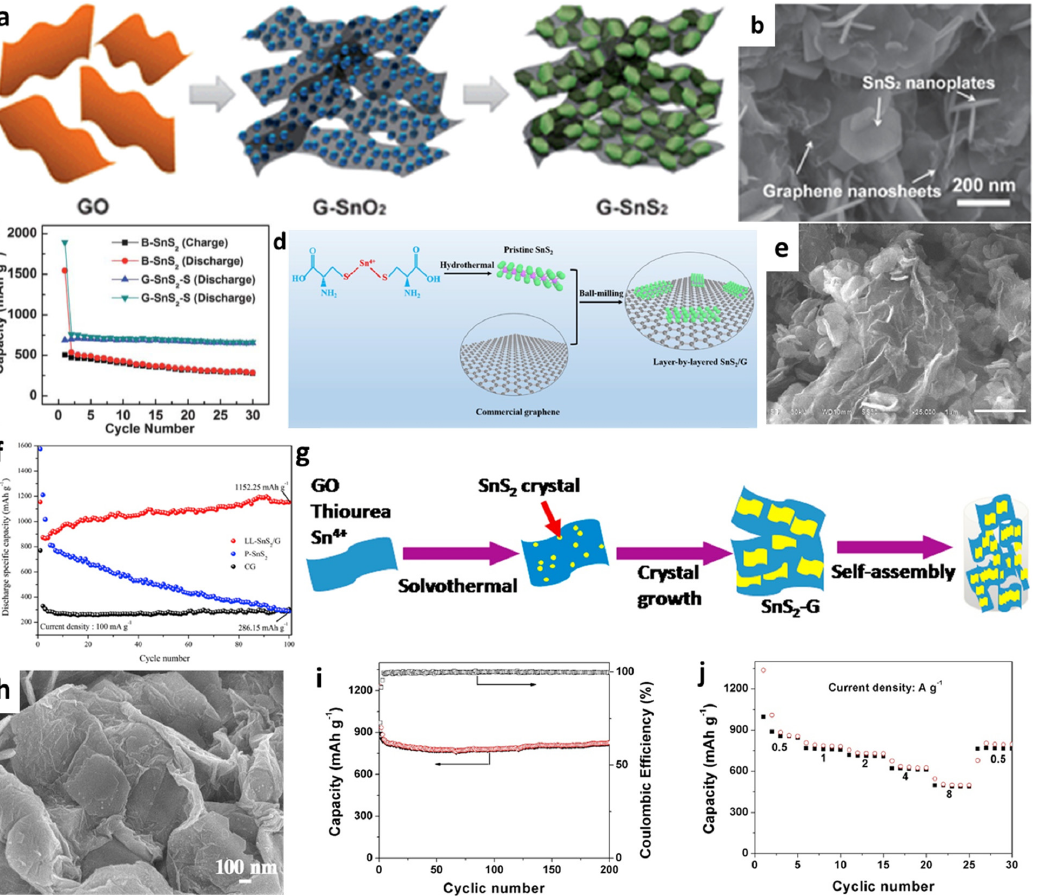
Figure 8. ( a ) Illustration of the formation, ( b ) an SEM image, and ( c ) cycling performance of the G–SnS 2 . Reprinted with permission from Ref. [142]. Copyright 2012 RSC. ( d ) Schematic illustration of the formation, ( e ) an SEM image, and ( f ) cycling performance of LL-SnS 2 /G. Reprinted